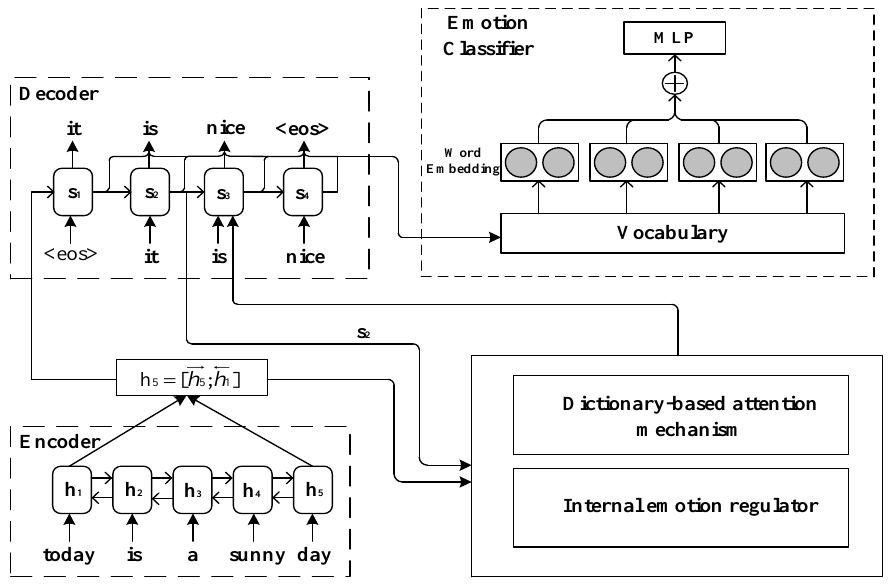
Figure 1. A dynamic emotional session generation (DESG) model based on Seq2Seq and a dictionary- based attention